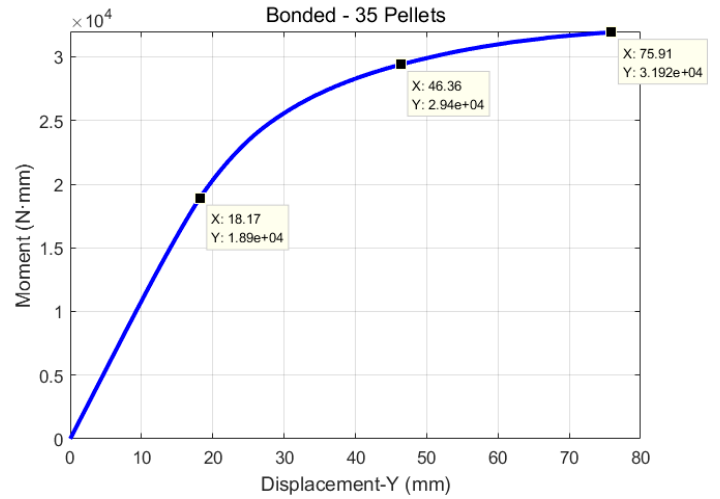
Figure 9. Moment versus maximum displacement diagram (fully de-bonded case). 3.5. Calibration of Material and Section Parameters of Simplified Beam Model For numerical simplicity, the spent fuel rod is degenerated into a beam made of homogeneous isotropic material with an annular cross section. The material properties and cross section parameters of this beam should be carefully chosen to make the mechanical responses of this beam close enough to those of the original detailed model discussed in Section 3.4. The ideal situation is that the behavior of this beam is identical to that of the detailed model throughout the whole ranges of loading. However, to find such model parameters may not be practically possible, and the existence of such a solution is not guaranteed. Thus, it is aimed in this work to have the simplified model fail under the critical load for the detailed model derived in Section 3.4, and the failure should be predictable with the same criteria as the detailed model. Because the failure criterion adopted is the plastic strain calculated from the curvature and the curvature is calculated from the displacement of three points along the centerline of the fuel rod, it is endeavored to make the equivalent beam model have the same displacement as with the detailed model for given moment loadings. By doing this, it is also expected that the load transferred from the collision with other fuel rods or a fuel basket in a cask can be simulated accurately because the beam model possesses the same flexural rigidity as with the detailed model. Three points along the moment-deflection curves are chosen for calibration, as depicted in Figures 9 and 10 as squares with their coordinates. The leftmost point is chosen in the elastic region, and the rightmost point corresponds to the critical moment that yields a 1% plastic